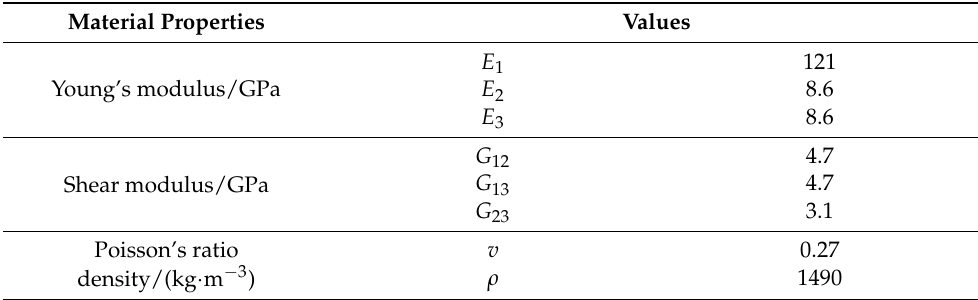
Table 1. Material characteristics of the carbon fiber/epoxy resin composite material.